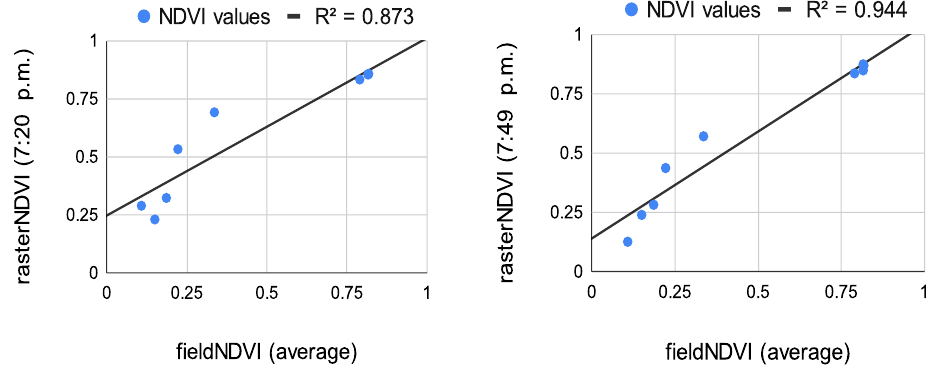
Figure 10. Correlation between the average NDVI values for the sample NDVI points and raster NDVI values from Sequoia ( left ) and multiSPEC 4c ( right ).